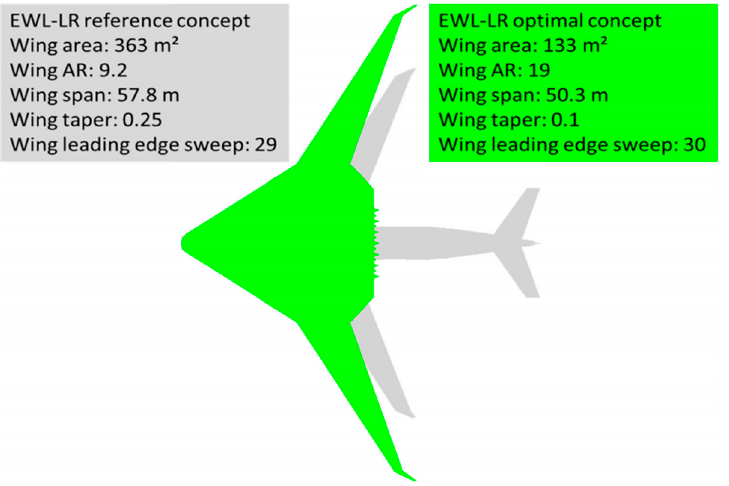
Figure 3. Geometric comparison between long range aircraft SE²A-LR and B777 outer wings planforms [2].